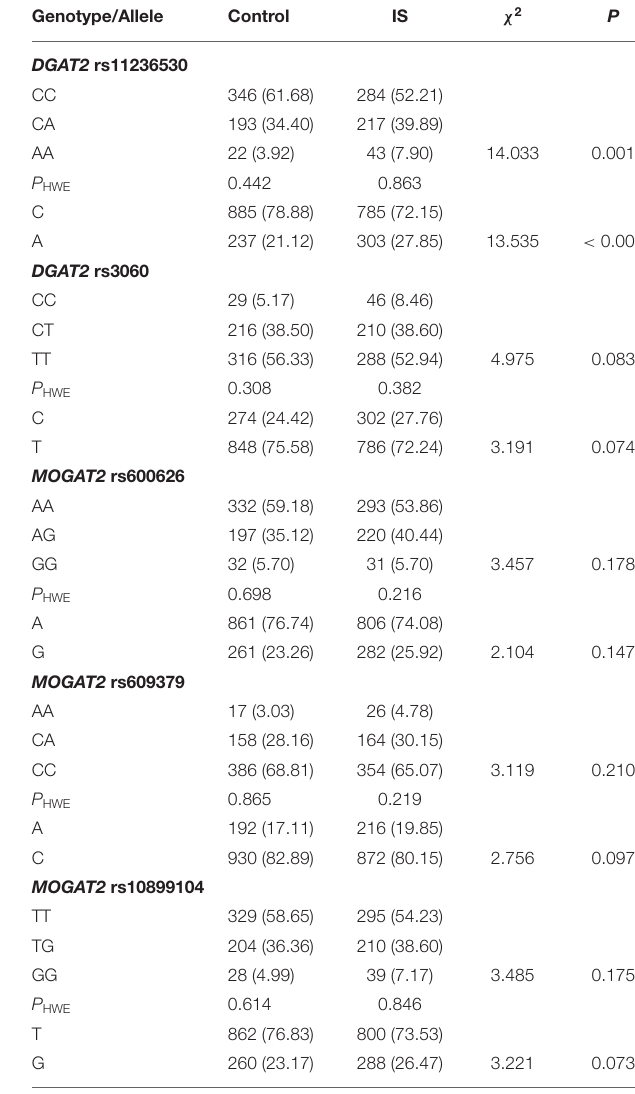
TABLE 2 | Genotype and allele frequencies of 5 DGAT2-MOGAT2 SNPs in control and IS groups [ n